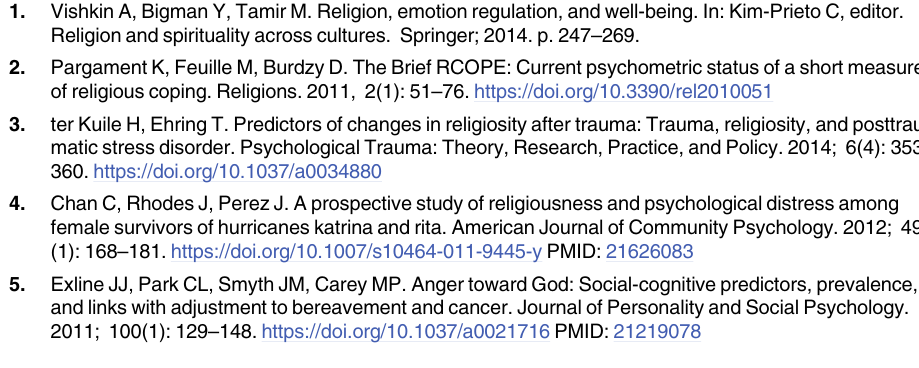
S1 Table. Exploratory factor analysis for COVID-19 belief items. Factors are indicated by bold values. S2 Table. Exploratory factor analysis for COVID-19 social distance motivation items. Fac- tors are indicated by bold values. S1 Fig. Eigenvalue scree plot for COVID-19 belief items. S2 Fig. Eigenvalue scree plot for COVID-19 social distancing motivation